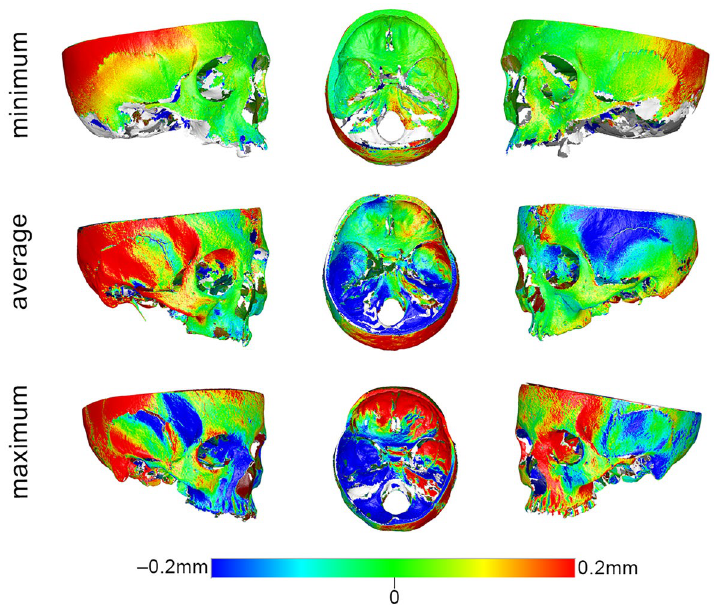
Figure 7. Color coded distance maps showing the difference between skulls embedded in water for different time periods (5 min set as reference and 15 min), depicted through selected models that corresponded to the minimum, average and maximum error detected in the pre-specified measurement areas. Zero distance between best-fit approximated repeated scans indicates zero effect of the embedding